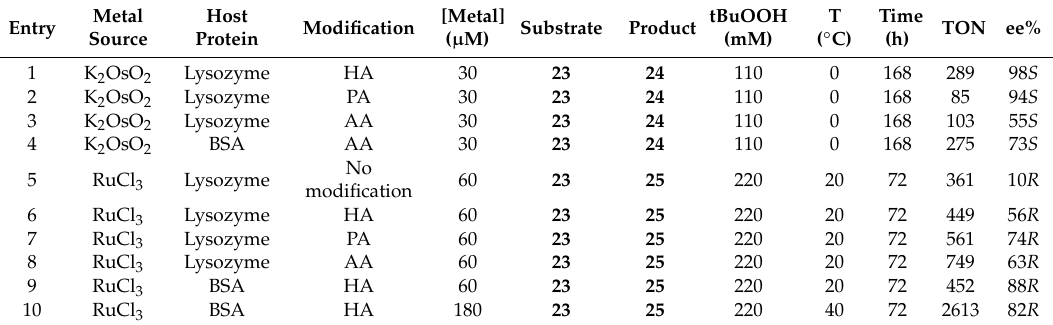
Table 2. Selected results of oxidation reactions catalyzed by acylated protein-bearing metal ions in organic solvents [47].